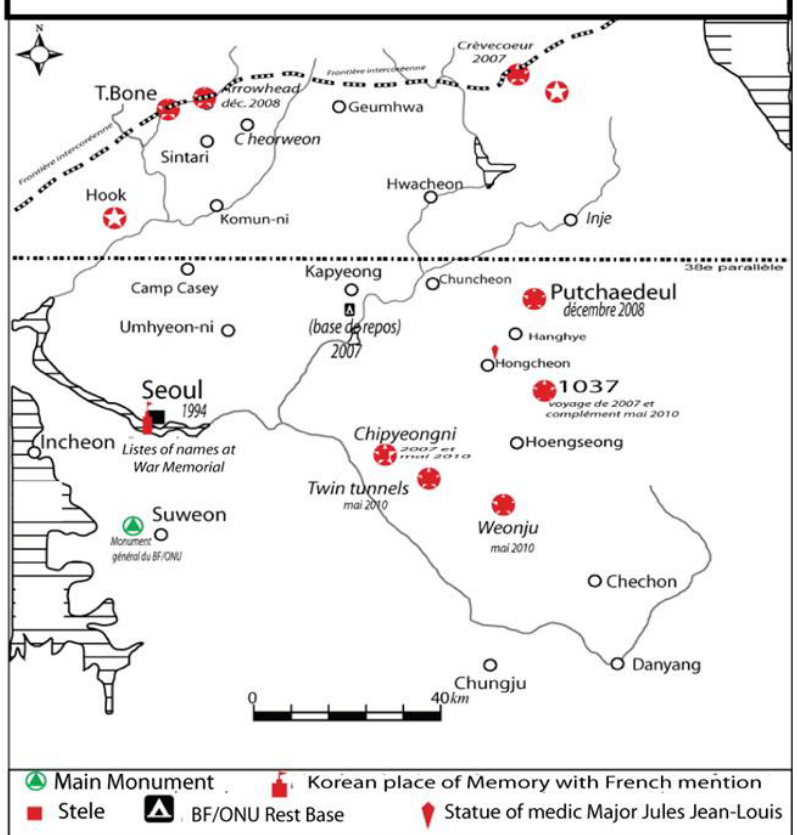
© Laurent Quisefit, 2013 . Figure 6. Arrowhead stele, facing the DMZ line.